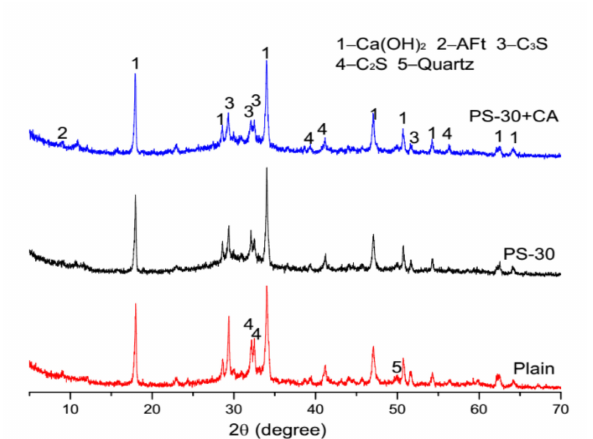
Figure 10. XRD patterns of plain pastes and cement pastes with 30% by mass of phosphorus slag and the chemical activator at 28